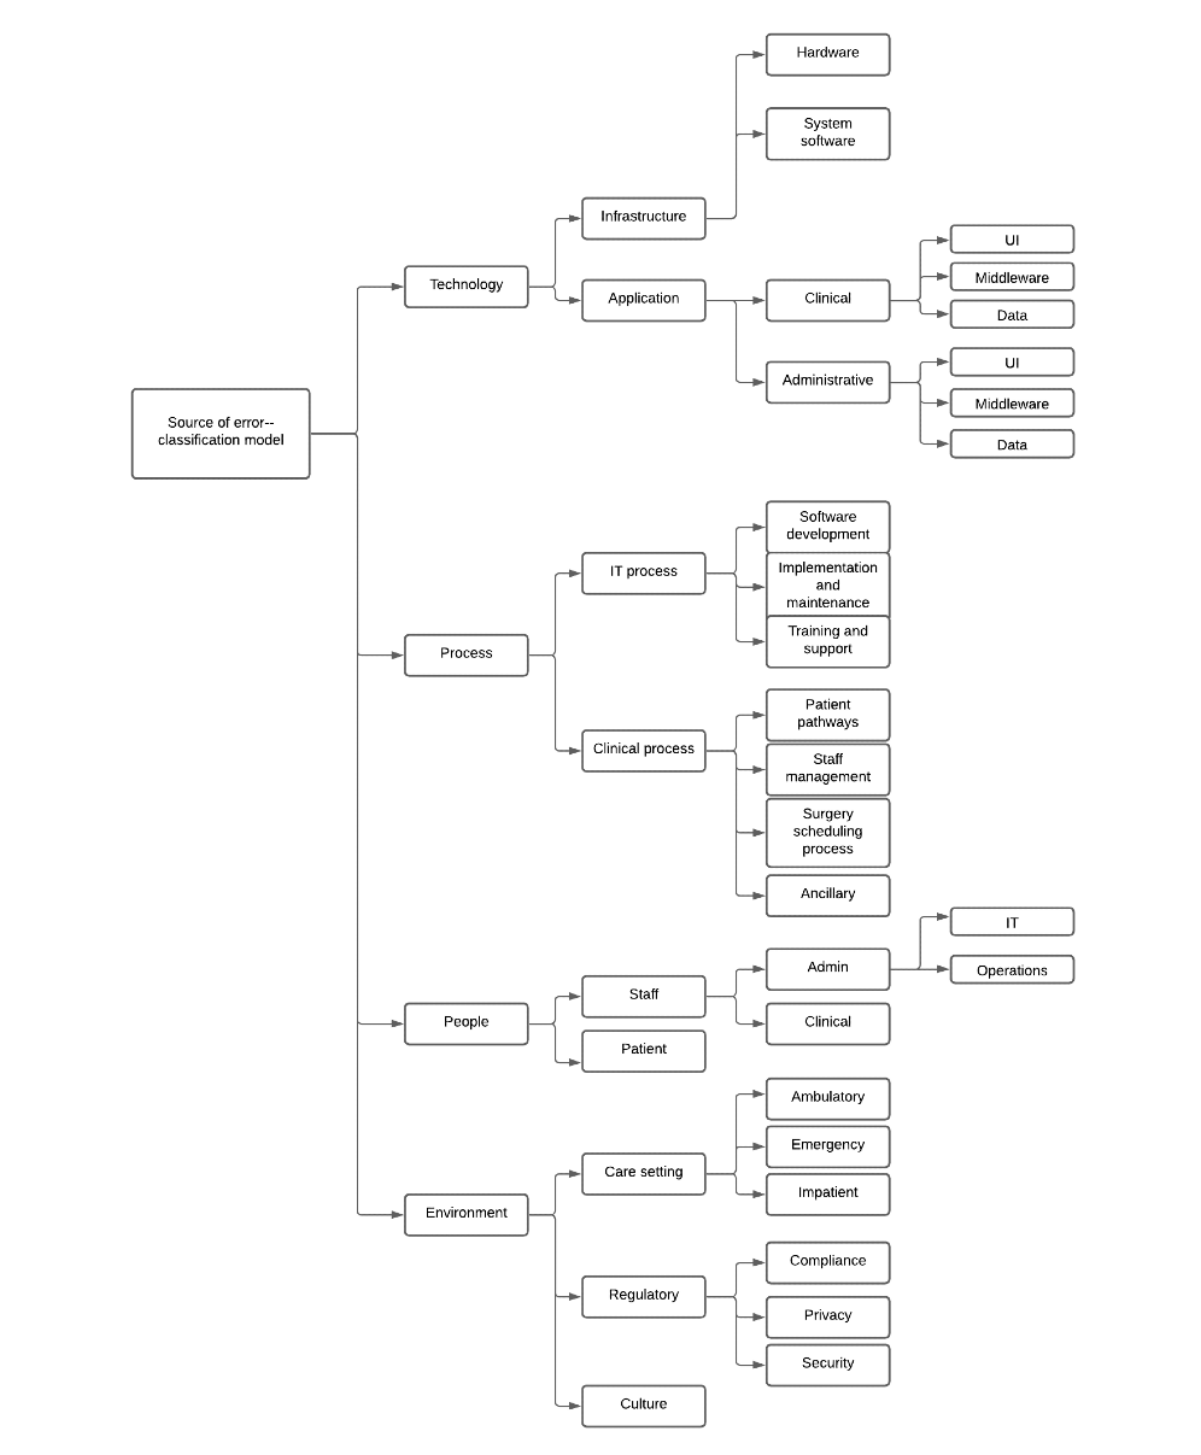
Figure 1. Error classification model. UI: user